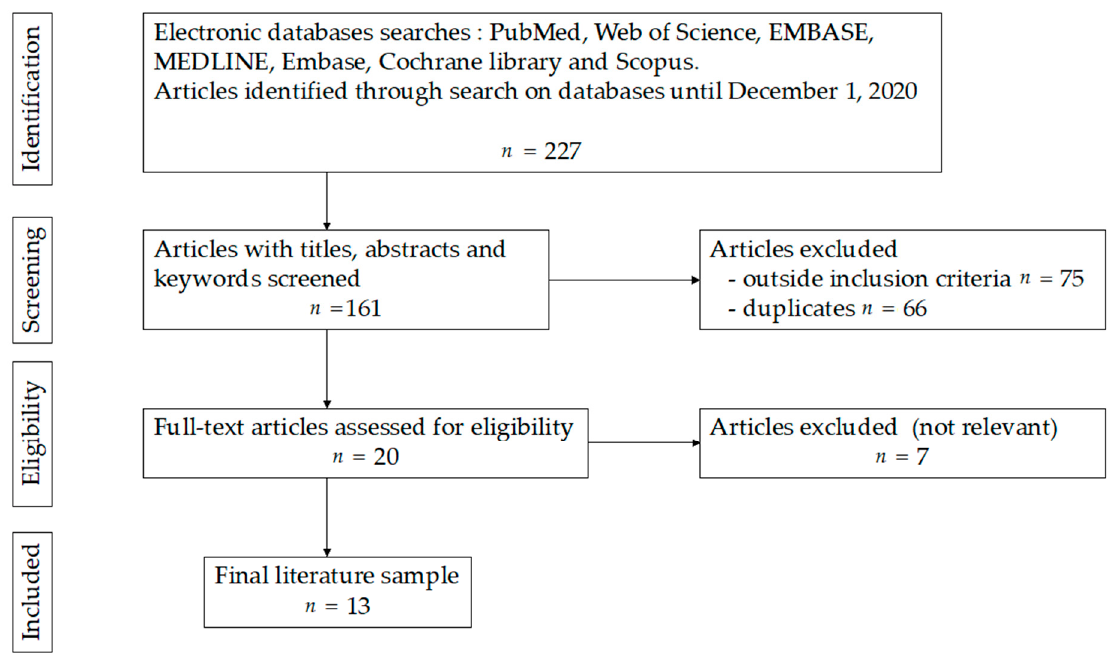
Figure 1. Study flow diagram for systematic review of the literature on liver